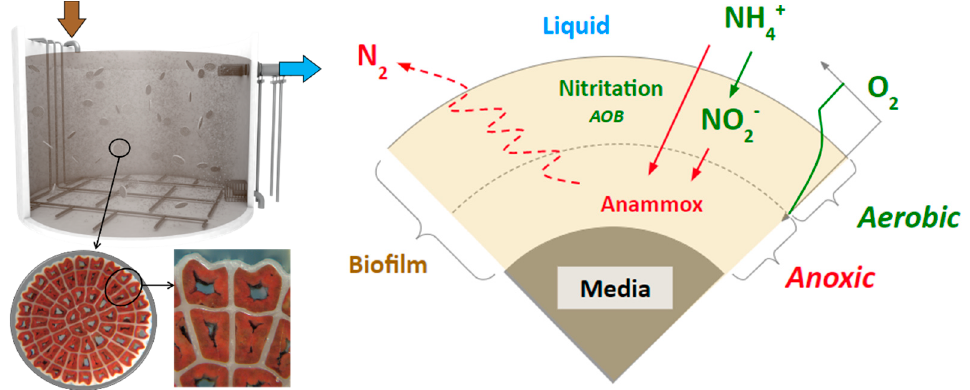
Figure 1. Biological mechanisms occurring in the biofilm of the AnoxK TM 5 carriers of the ANITA TM Mox MBBR process.